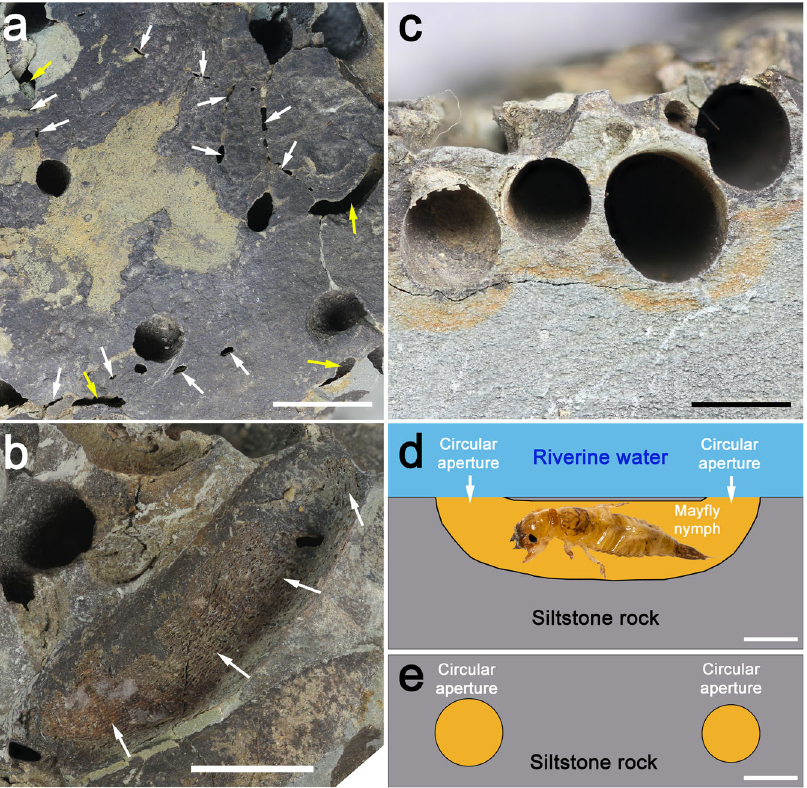
Fig. 5 Morphological features and neoichnological model of the rock-boring may fl y species Languidipes lithophagus sp. nov. traces from the middle section of the Bago River, Myanmar. a Close-up view of the apertures (plan view). The white arrows show minute fractures tracing the upper layer of the borings. The yellow arrows show larger fractures corresponding to the initial stage of rock erosion leading to the origin of grooves (i.e., borings, the upper layer of whose was lost). b Plan view of a groove with concave bottom originated via partial erosion of the boring. The groove bears fragments of a silky substance produced by the tracemaker (shown by white arrows). c Transverse cross- section of the borings showing their circular tunnel-like shape. Neoichnological model of the boring: lateral view of the longitudinal section ( d ) and plan view of the two apertures at the rock surface ( e ). Orange fi lling indicates the boring. Scale bars = 10 mm ( a ) and 5 mm ( b – e ). (Photos: Artyom A. Lyubas; Graphic Art: Ivan N. Bolotov).